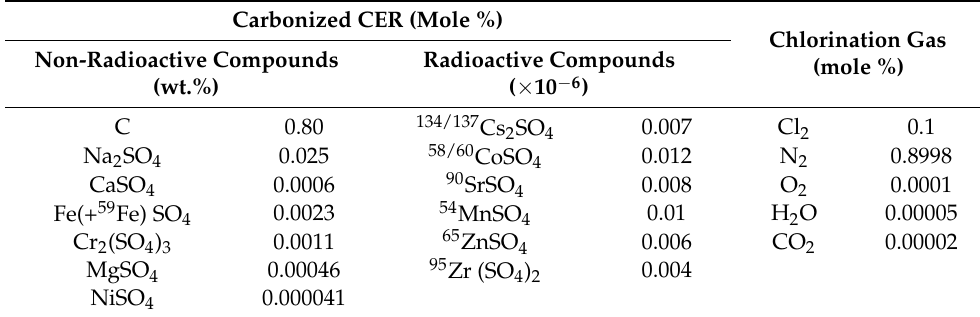
Table 1. Chemical composition of carbonized CER and chlorination gas for the equilibrium model calculation for the determination of the appropriate chlorination reactor condition. Carbonized CER (Mole %)